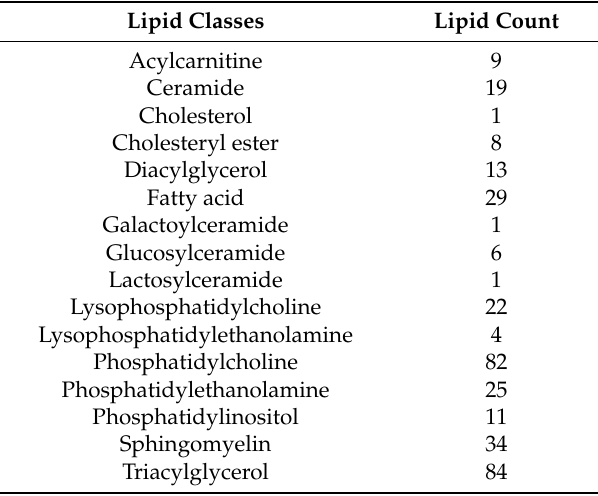
Table 1. Listing of lipid classes in the current